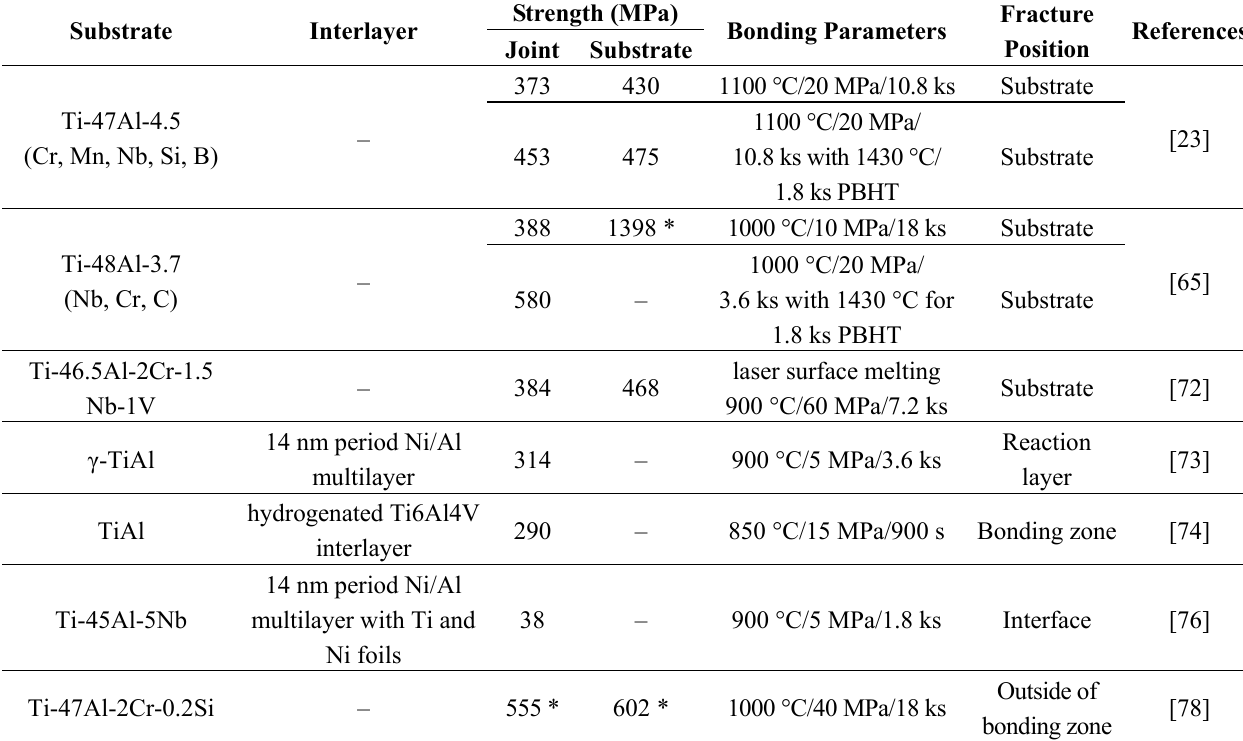
Table 4. The mechanical properties of titanium aluminide diffusion bonded